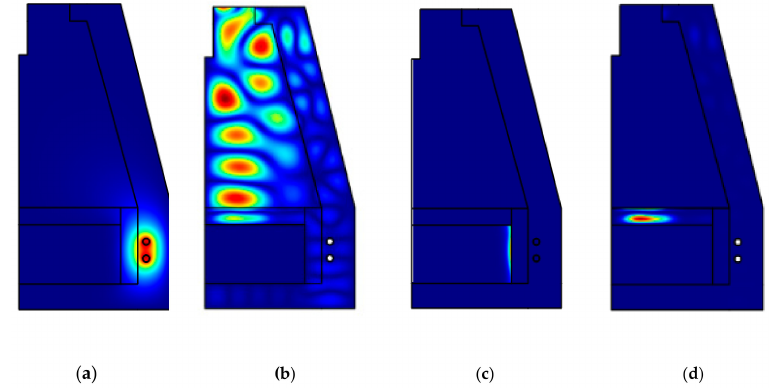
Figure 2. Surface plots of: ( a ) Electric field strength in case of pure induction heating (max = 82 V / m); ( b ) Electric filed strength in case of pure microwave heating (max = 9488 V / m); ( c ) Power density in case of pure induction heating (max = 1.34 × 10 6 W / m 3 ); ( d ) Power density in case of pure microwave heating (max = 8.48 × 10 4 W / m 3